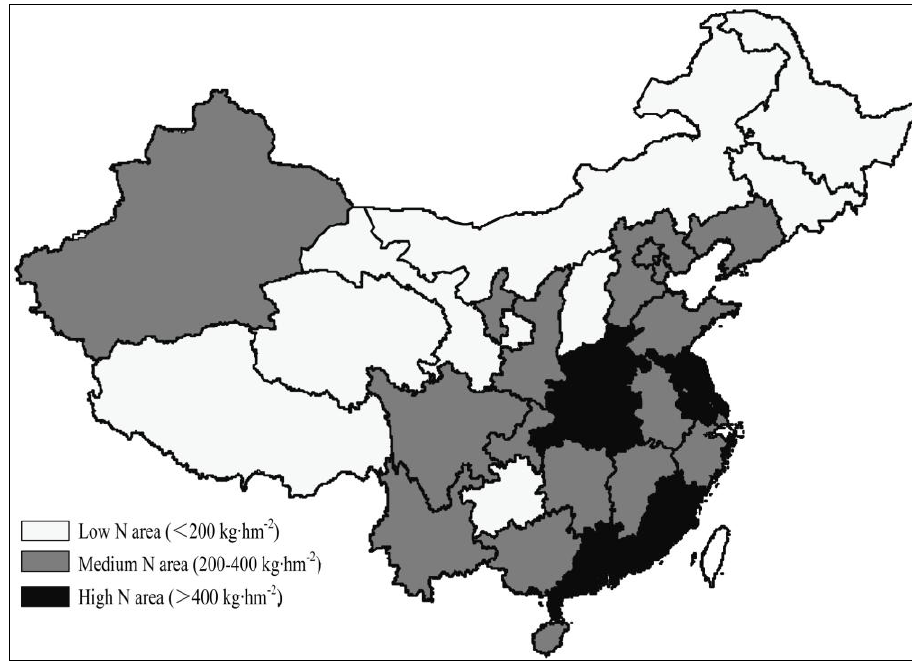
Fig. 7. Provincial differences in N fertilizer use intensity (Source: Liu,